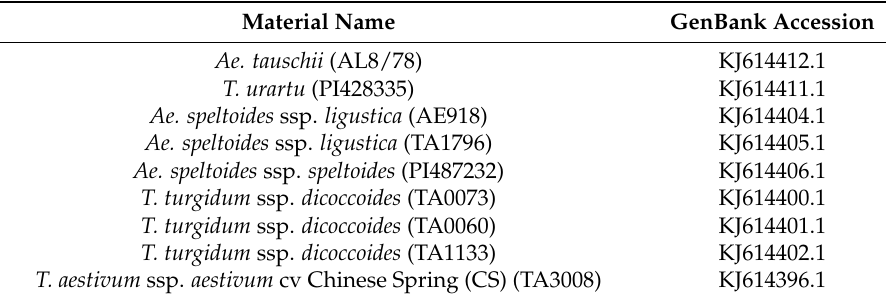
Table 1. Information of complete chloroplast genome for comparative analysis of RNA editing sites in protein-coding genes among Poaceae